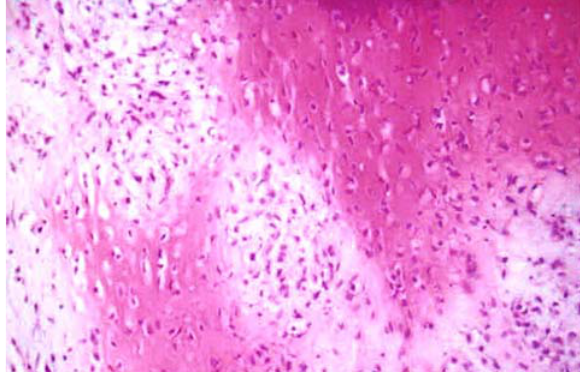
Figure 2 – Bone differentiation beside areas of poorly differen- tiated carcinoma (HE,